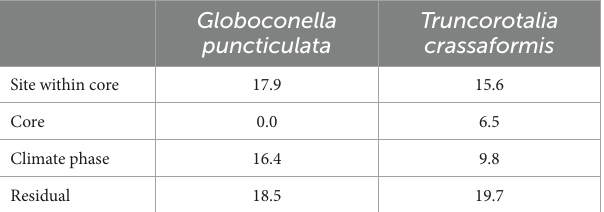
TABLE 2 Standard deviation of the random effect variance explained by spatial and temporal components of morphological change for the minimum adequate models.